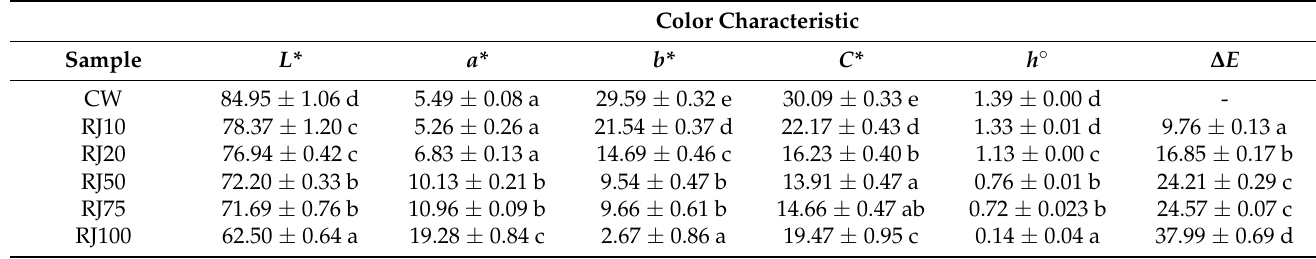
Table 3. Assessment of wafer color